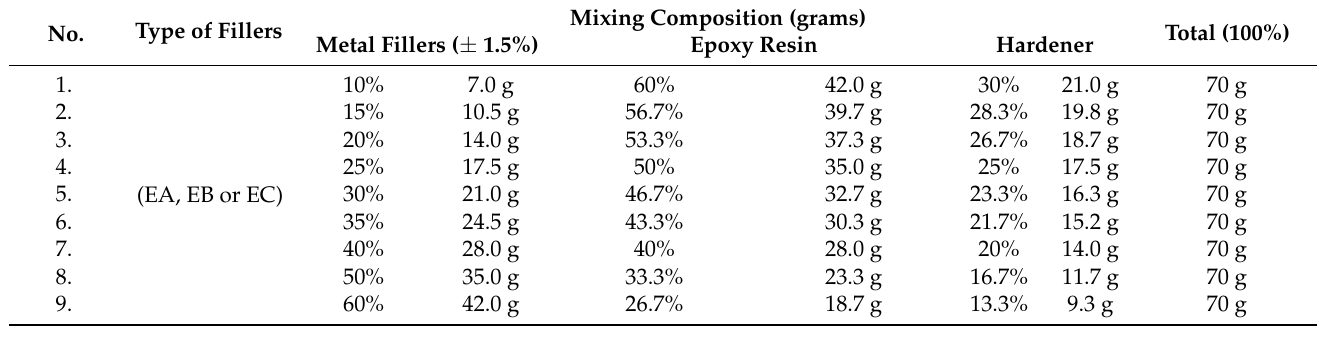
Table 2. Composition of MEC for one set of specimens.